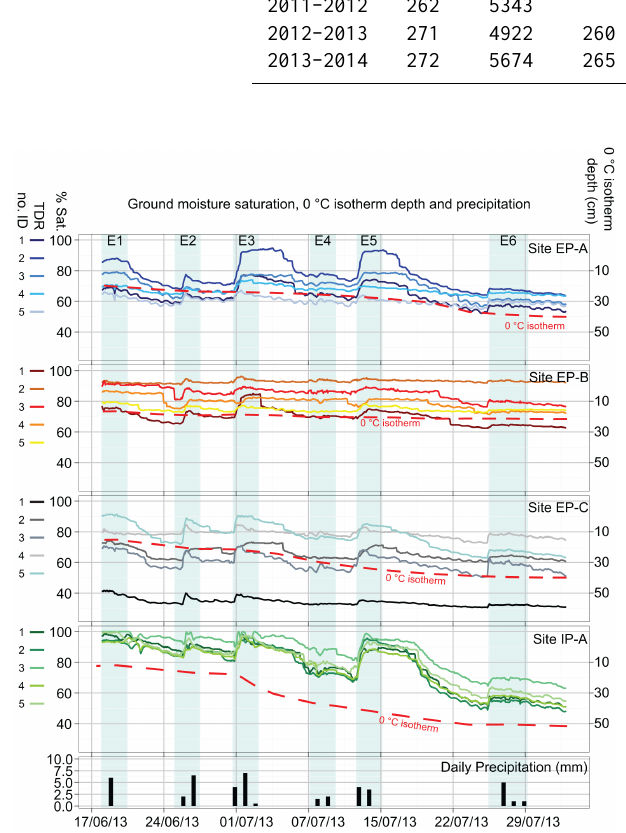
Figure 4. Moisture readings for the near surface of sites EP-A, EP- B, EP-C and IP-A during the summer of 2013 (Fig. 3). Daily precip- itation readings indicated six rain events through the summer, iden- tified as E1–E6. Propagation of the thaw front in the active layer evolution is identified as the 0 ◦ C isoline for each site. Moisture lev- els in percent saturation decreased following active-layer depth for all sites except EP-B.